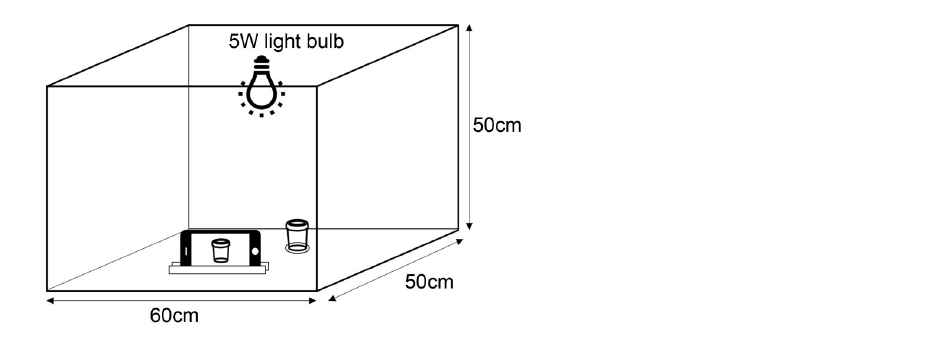
Fig 1. Photo booth setup to capture urine colour. The schematic of the photo booth along with placements of urine bottle and light source.